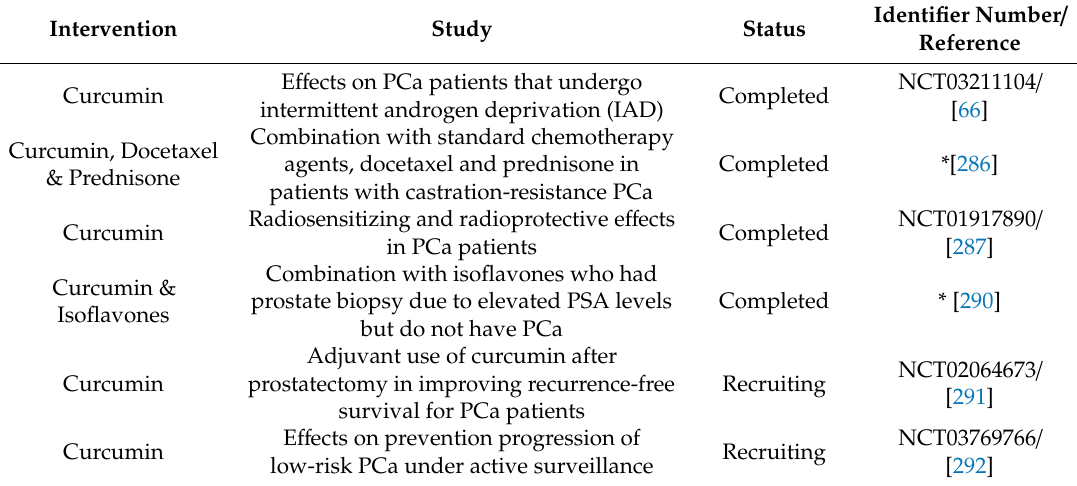
Identifier Number / Reference NCT03211104 / Completed [66] Completed *[286]